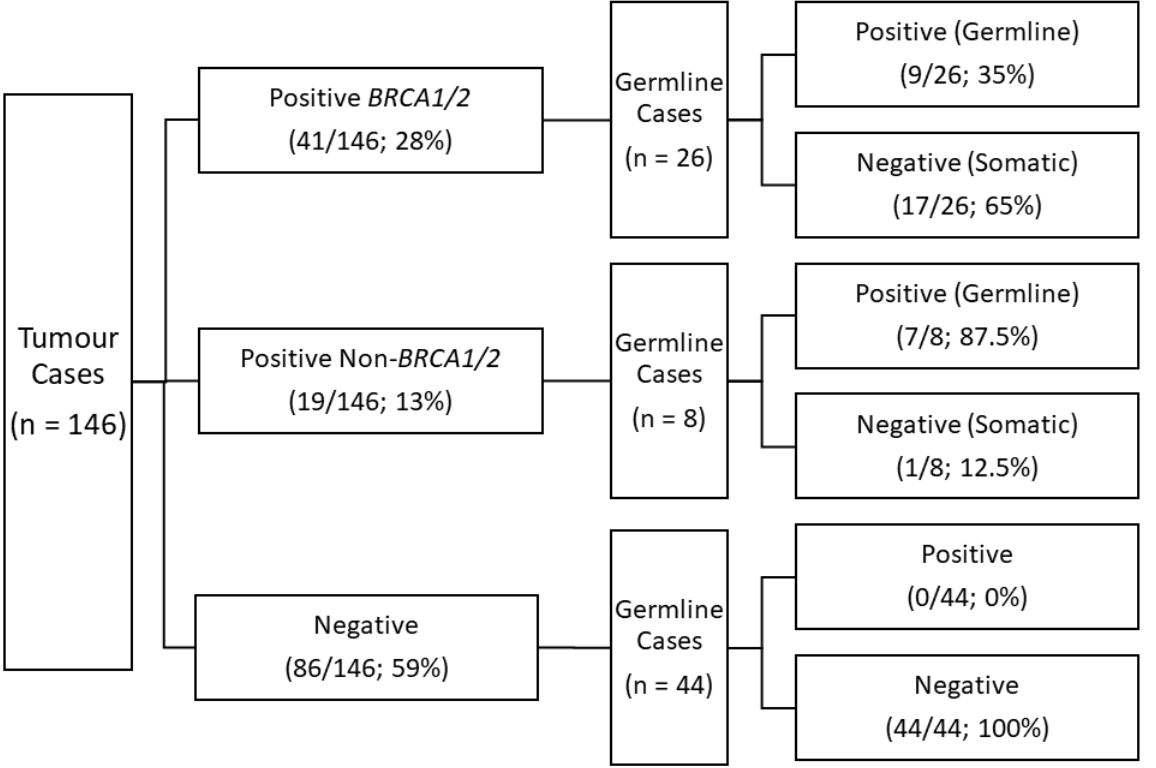
Figure 1. Summary of HGSC tumour and matched germline results. Tumour samples were divided into three groups: 1. Tumour cases testing positive for a BRCA1 or BRCA2 Tier I/II variant; 2. Tumour cases testing positive for a Tier I/II variant in an HCP gene excluding BRCA1 , BRCA2 , or TP53 ; and 3. Tumour cases with no detected Tier I/II variant. Cases that carried a BRCA1 or BRCA2 variant, as well as a second variant in another gene, were classified as BRCA1/ 2-positive. Of the cases with tumour results, matched germline analysis was assessed in a subset of cases. Tumour variants that were also present in germline analysis were deemed inherited while all tumour variants absent from germline analysis were considered somatic. Matched negative tumour cases showed 100% concordance.